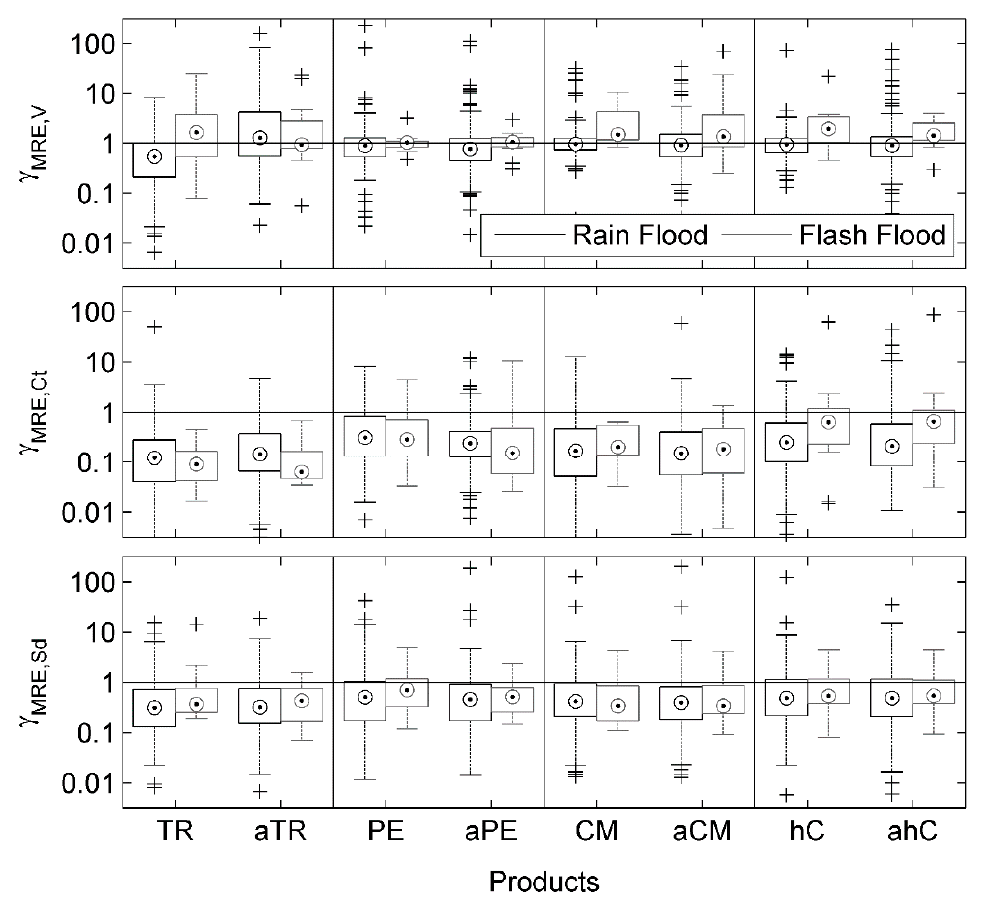
Figure 7. Ratio of mean relative error for the depth ( top panel ); centroid ( middle panel ) and spreadness properties ( bottom panel ). Cross corresponds to outlier and circles represent median.